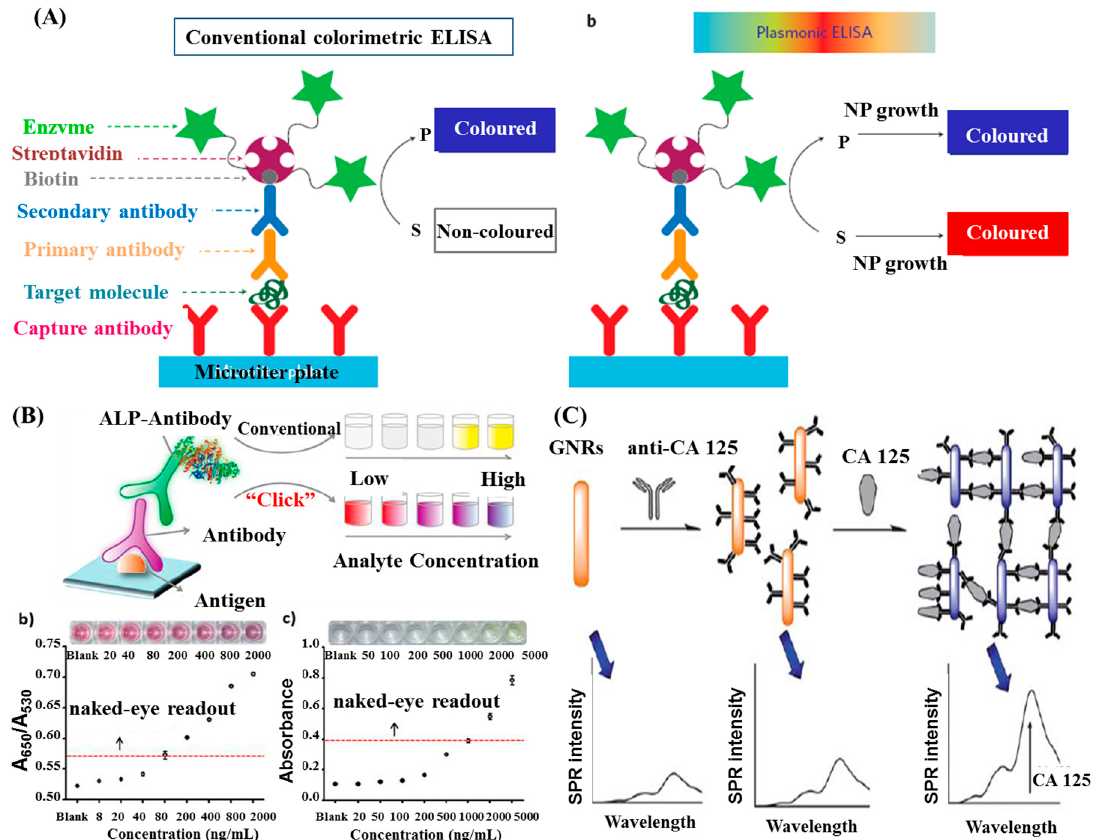
Figure 3. ( A ) Schematic representation of the sandwich ELISA format used here and two possible signal generation mechanisms (S, substrate; P, product; NP, nanoparticle). Reproduced with permission from reference [82]. ( B ) A comparison between CuAAC-mediated plasmonic ELISA and conventional ELISA. Reproduced with permission from reference [84]. ( C ) Schematic representations of CA 125 detection using plasma resonance scattering properties of gold nanorods. Reproduced with permission from reference [6]. Copyright Springer Nature, 2012; Copyright American Chemical